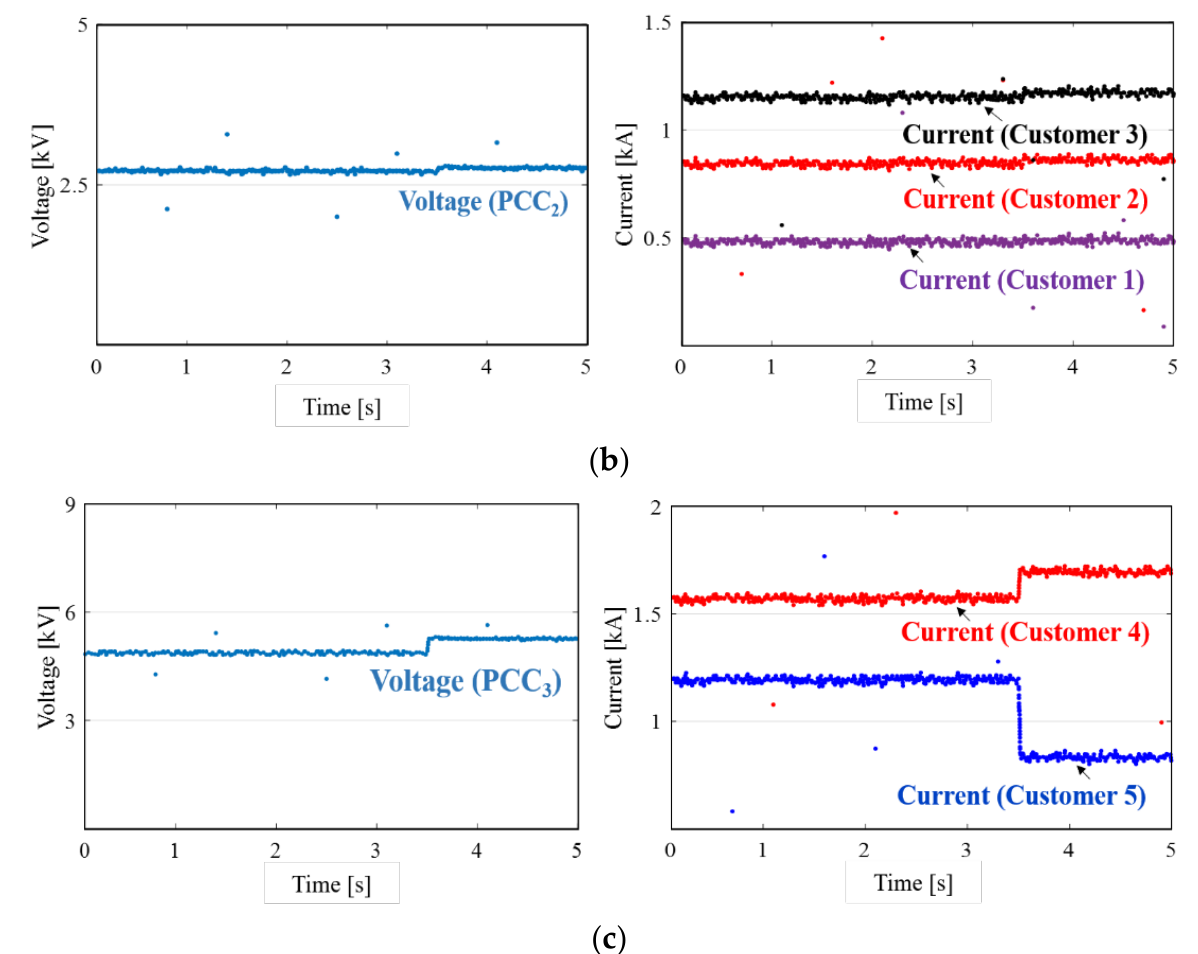
Figure 10. The measured voltage and currents at each PCC. ( a ) The PCC 1 voltage and the currents of feeders 1 and 2. ( b ) The PCC 2 voltage and the currents of customers 1, 2, and 3. ( c ) The PCC 3 voltage and the currents of customers 3 and 4.